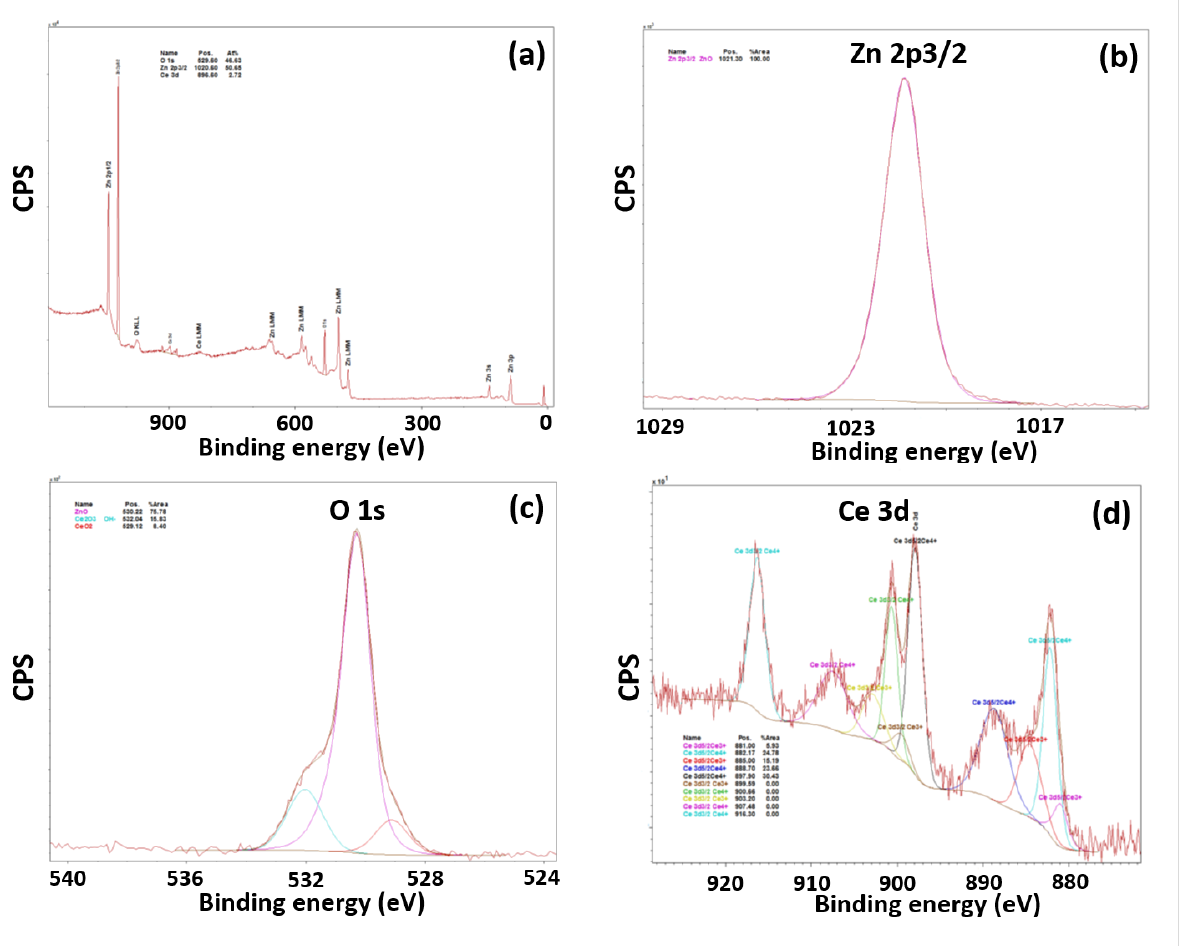
Figure 3: XPS analysis of the prepared ZnO:Ce (5%) rods. (a) Survey scan, and high resolution scans of (b) Zn 2p region, (c) O 1s region, and (d) Ce 3d region.